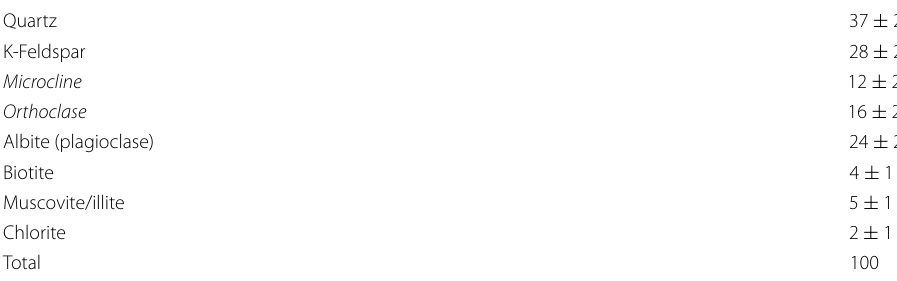
Table 1 Mineral content of G2M-A granite in wt.% from XRD analysis Quartz 37 ± 2